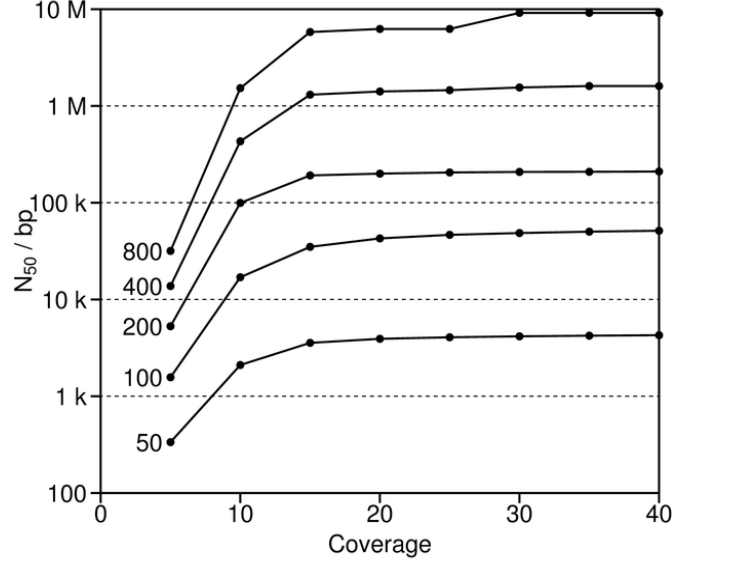
as a function of both read length (50 to 800 bases) and coverage. These Figure 6. N 50 simulations are based on human chromosome